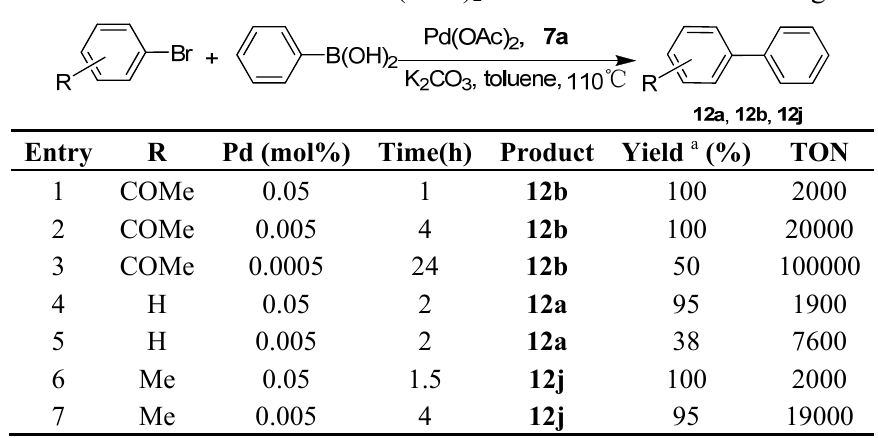
Table 4. The activities of Pd(OAc)